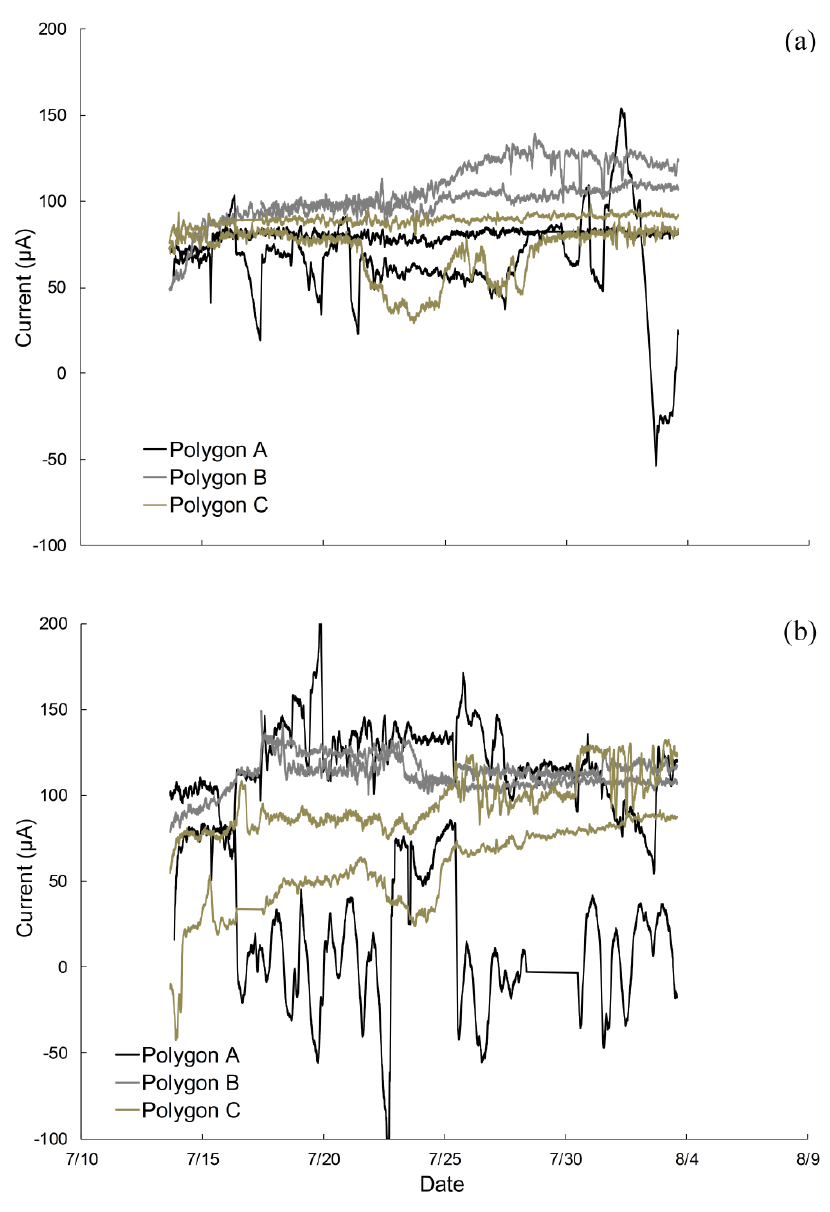
Figure A1. Electrical current from poised electrodes at shallow ( a ) and deep ( b ) depths recorded by microcontroller-based potentiostats. At the shallow depth ( a ), all electrodes begin with similar currents and then change over the course of the five-week experiment, with the currents in polygon A increasing by ~40 µA in the middle of the experiment. Electrical current is more erratic in electrodes at deep depths ( b